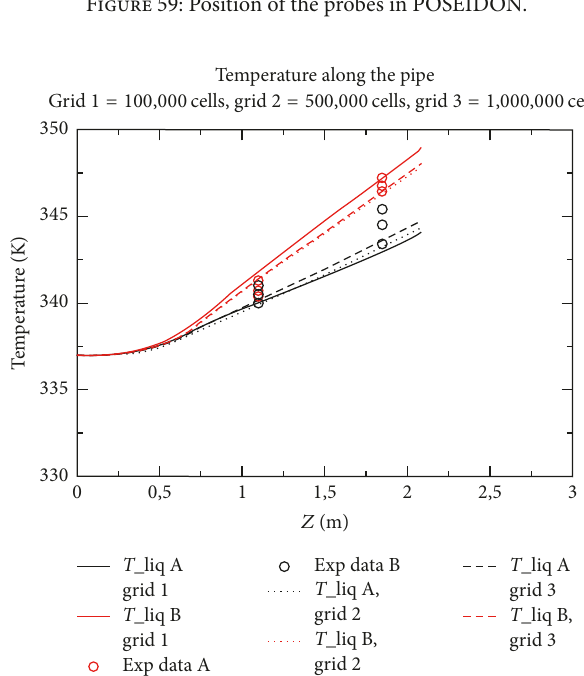
Figure 60: Axial profiles of liquid temperature in POSEIDON obtained with the new